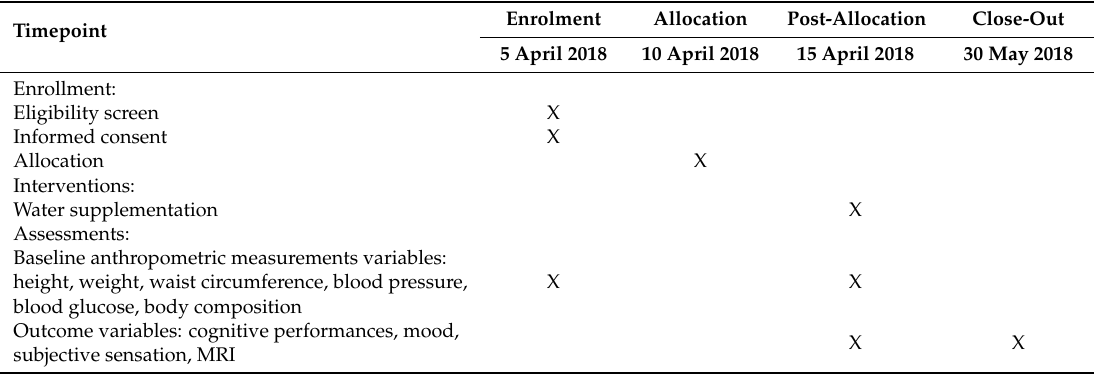
Table 2. The schedule of enrolment, interventions, and